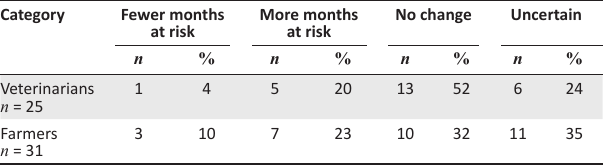
TABLE 3: Opinions on change in heartwater occurrence compared with previous years. Category Fewer months at risk